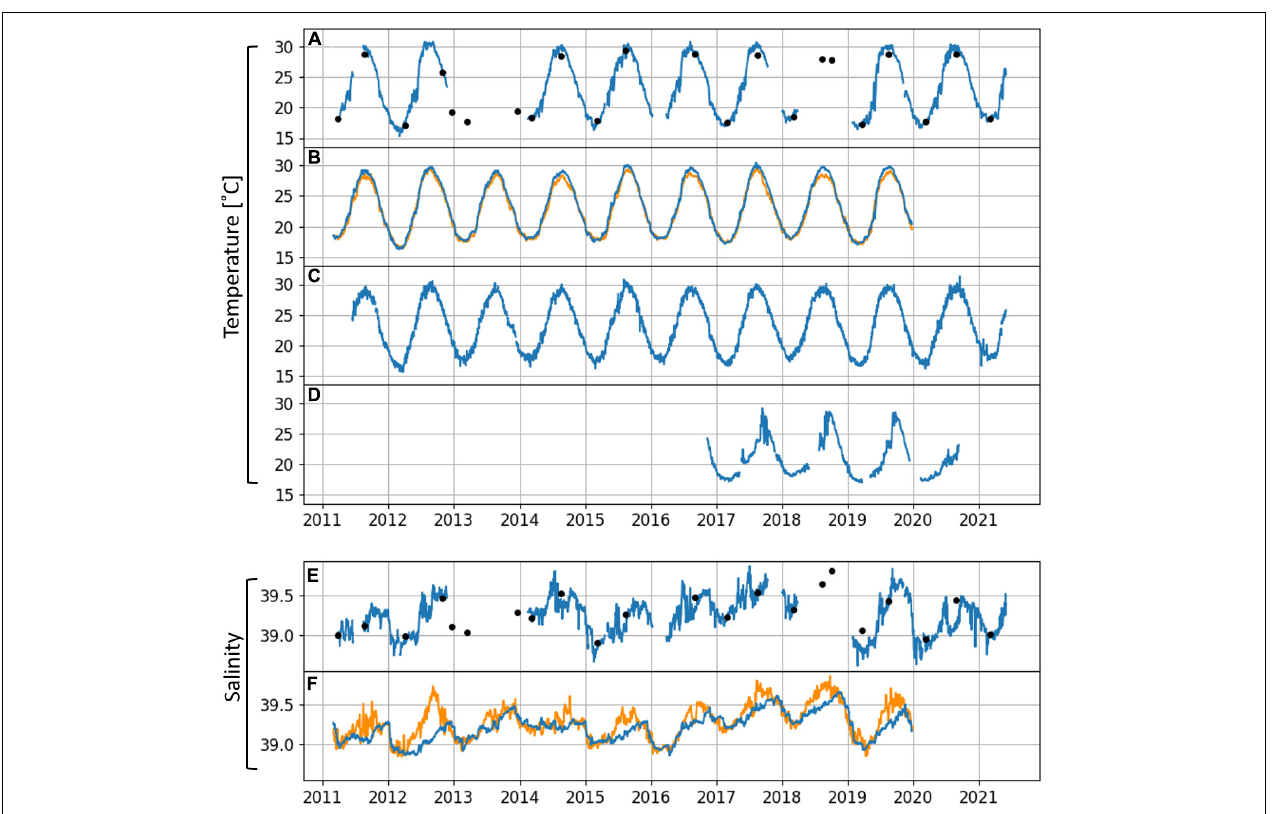
FIGURE 2 | Temperature [ A: Hadera CTD, B: CMEMS reanalysis CRA (blue) and OWRA (orange), C: SST, and D: DeepLev] and salinity [ E: Hadera CTD and F: CMEMS reanalysis CRA (blue) and OWRA (orange) time series used for lag correlations and additional analysis]. Haifa section open water stations averaged surface values (upper 20 m) in black dots (A,E) .